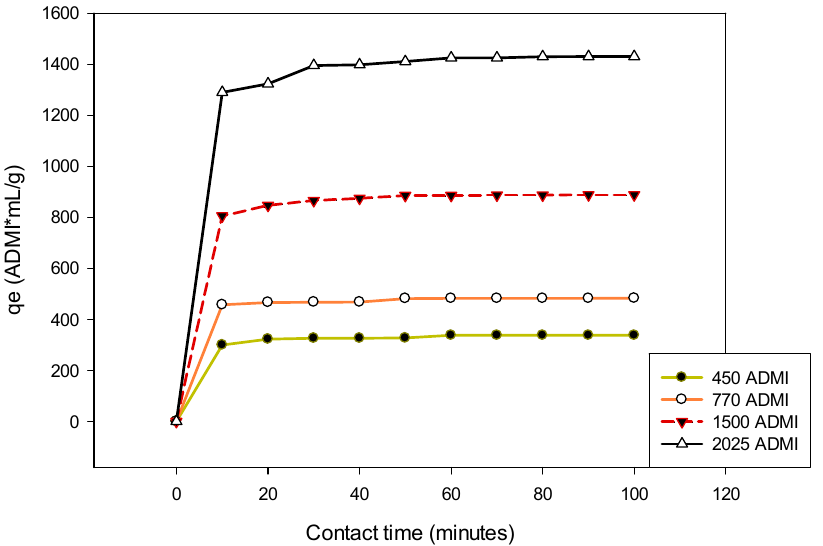
Figure 8. Change in adsorption capacity with contact time at a varied initial concentration (at 27 °C).